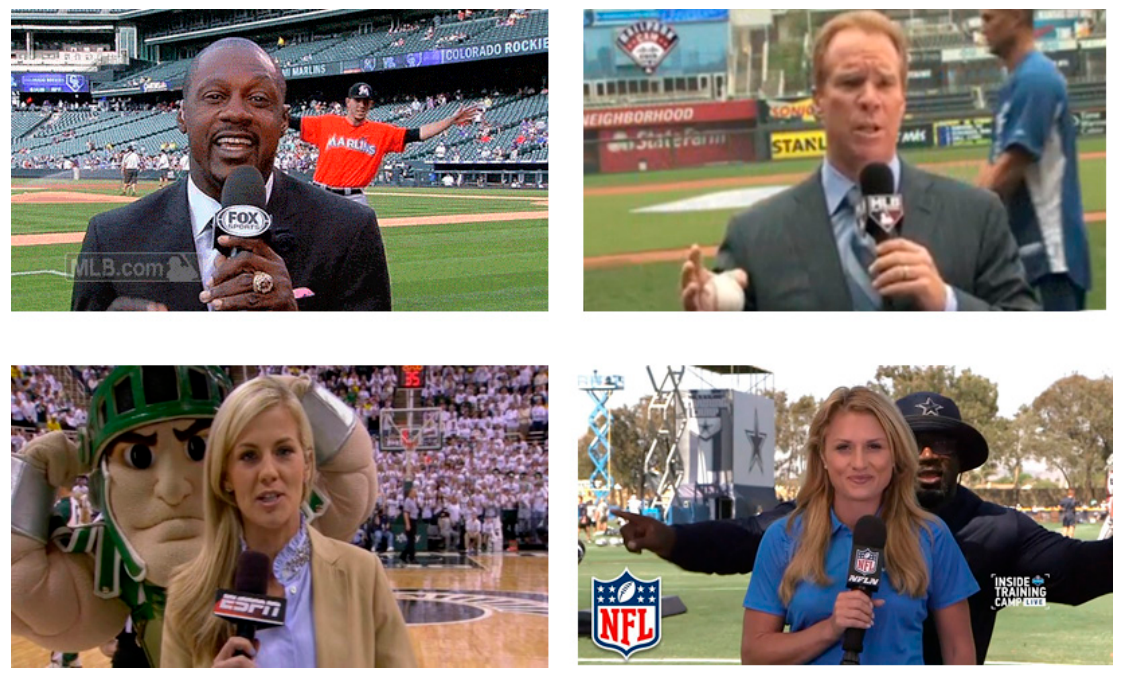
Figure 2. Examples of photobombing in real sport events.